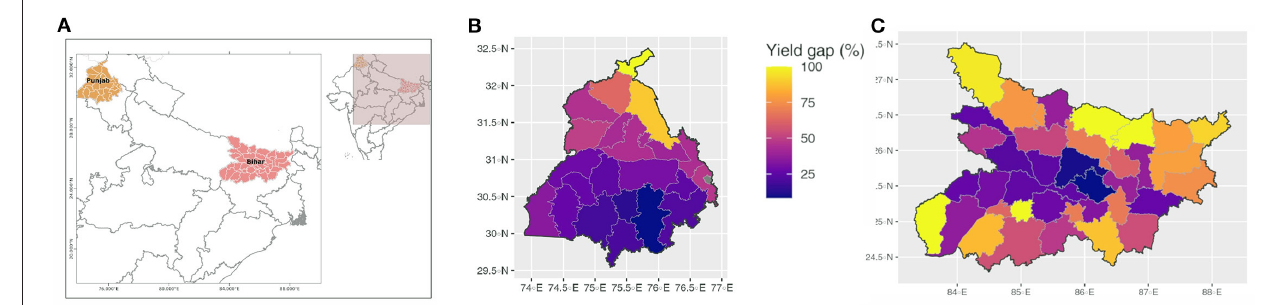
FIGURE 1 | Location and wheat yield gap in the study areas. (A) Study area location; (B) Wheat yield gap in Punjab; (C) Wheat yield gap in Bihar. Data sources: Agro-climatically attainable yields, developed by the International Institute for Applied Systems Analysis (IIASA) and the Food and Agriculture Organization of the United Nations (FAO) using the Agro-Ecological Zones (AEZ) methodology, were obtained from http://www.gaez.iiasa.ac.at/. In this figure, the baseline results of climate and agro-climatic analysis (based on mean climatic data for the period 1961–1990 and data from individual historical years of 1901 to 2009) from the Global Agro-Ecological Zoning (GAEZ) models were used in this process to generate data. The GAEZ models are updated frequently, and the present study used the latest available version of the model. Individual district-wise mean values for all management regimes were obtained from respective potential yield images, using zonal statistics in QGIS. The other data sources include area and production statistics, Ministry of Agriculture and Farmers Welfare, Government of India, www.aps.dac.gov.in/APY/Public_Report1.aspx, and District maps for India